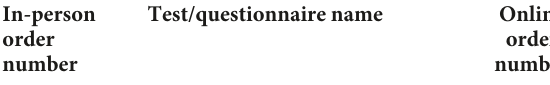
TABLE 1 List of tests and questionnaires administered at all visits in-person and